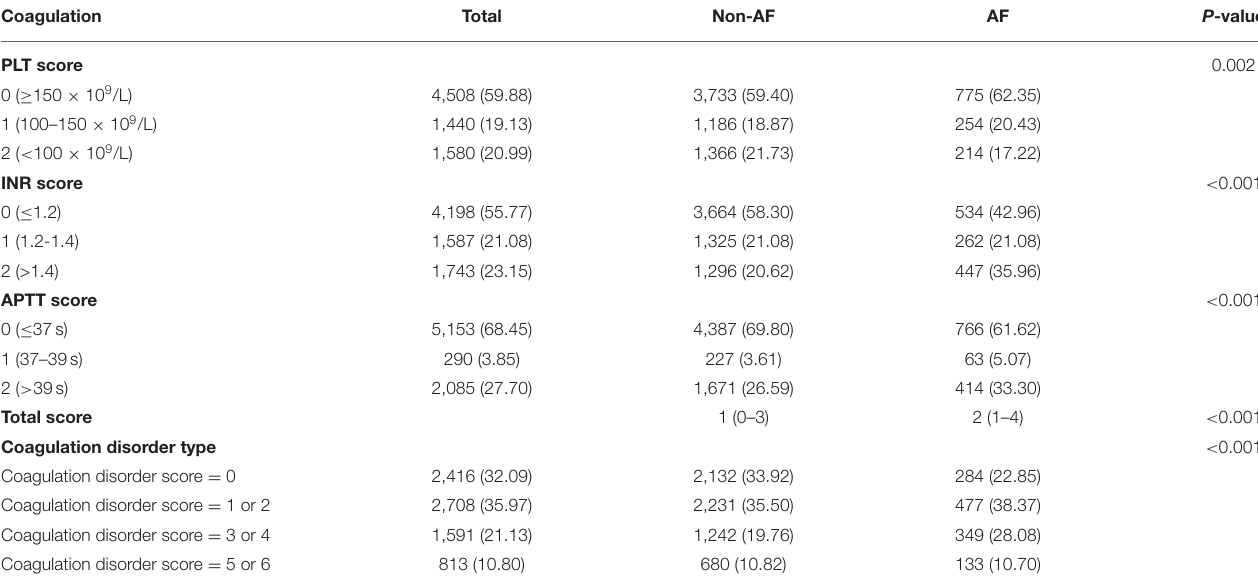
TABLE 2 | Comparisons of early coagulation disorder between AF group and Non-AF group before